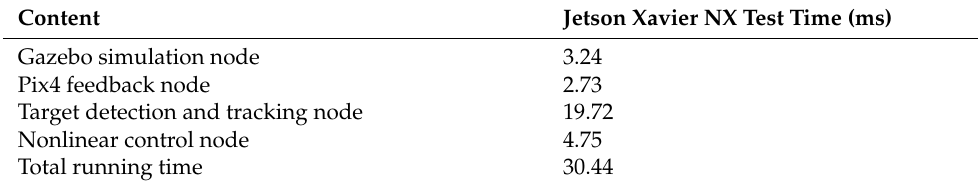
Table 2. Node test